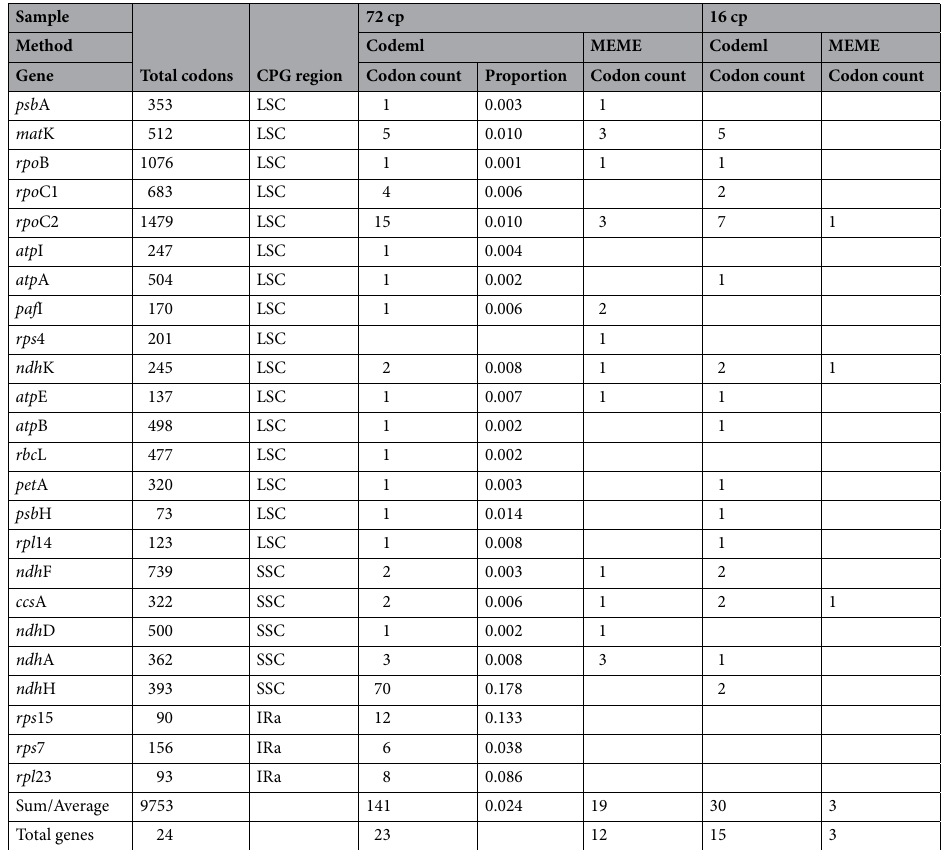
Table 3. The extents of codons showing positive selection in the chloroplast (cp) genes in two sets of samples (16 cp genome assemblies generated in this study and published 72 cp genome sequences) obtained from the tests by two methods (PAML codeml and Hyphy MEME). Note that the total codon count for each associated gene was obtained from the coding protein sequences of T. aestivum (MG958554). CPG chloroplast